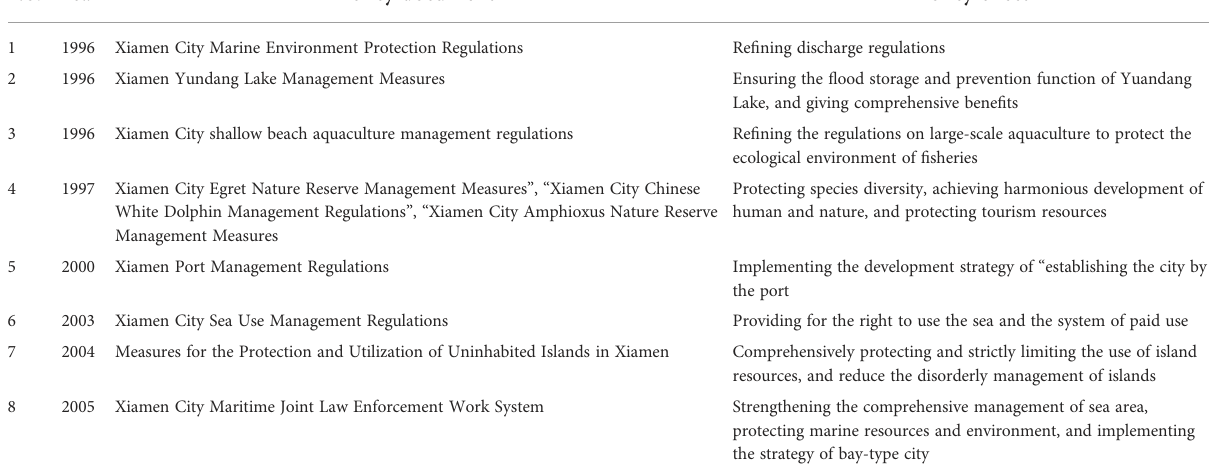
TABLE 2 Laws and regulations on ICZM in